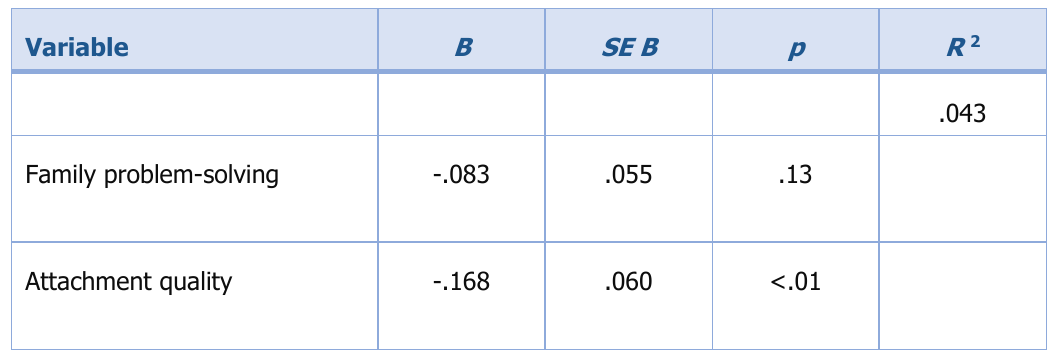
Table 3. Path Model Summary for Family Problem-Solving and Attachment Quality Predicting Parent-Reported Risk-Taking (N =